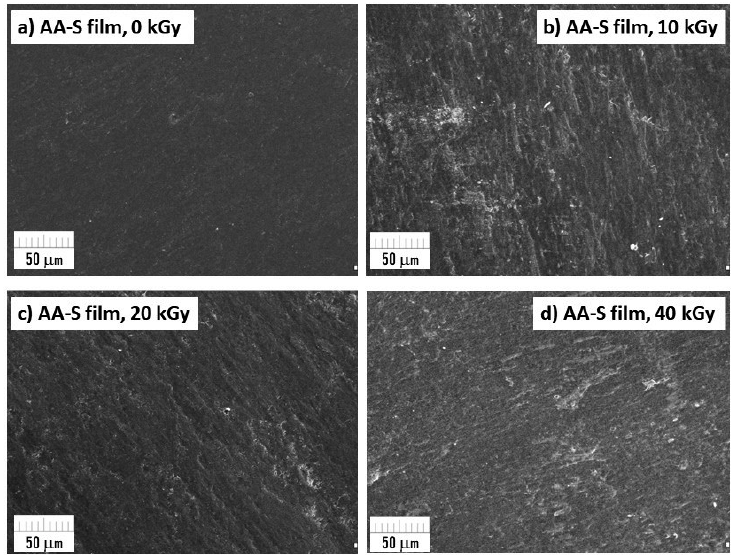
Figure 9. SEM micrographs of AA-S films (0, 10, 20; 40 kGy) taken at 500× magnification. Regardless of the dose used, neither structural changes nor physical damage during